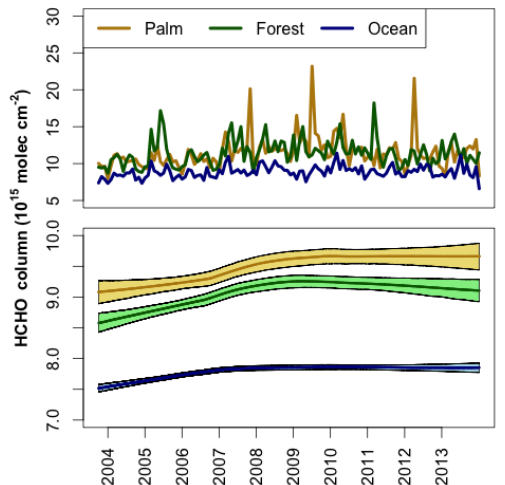
Figure 16. A monthly mean and LOWESS time series of NO 2 from OMI in the three separate regions of northern Borneo (see Fig. 13). The LOWESS shaded regions represent the 95% confidence inter-